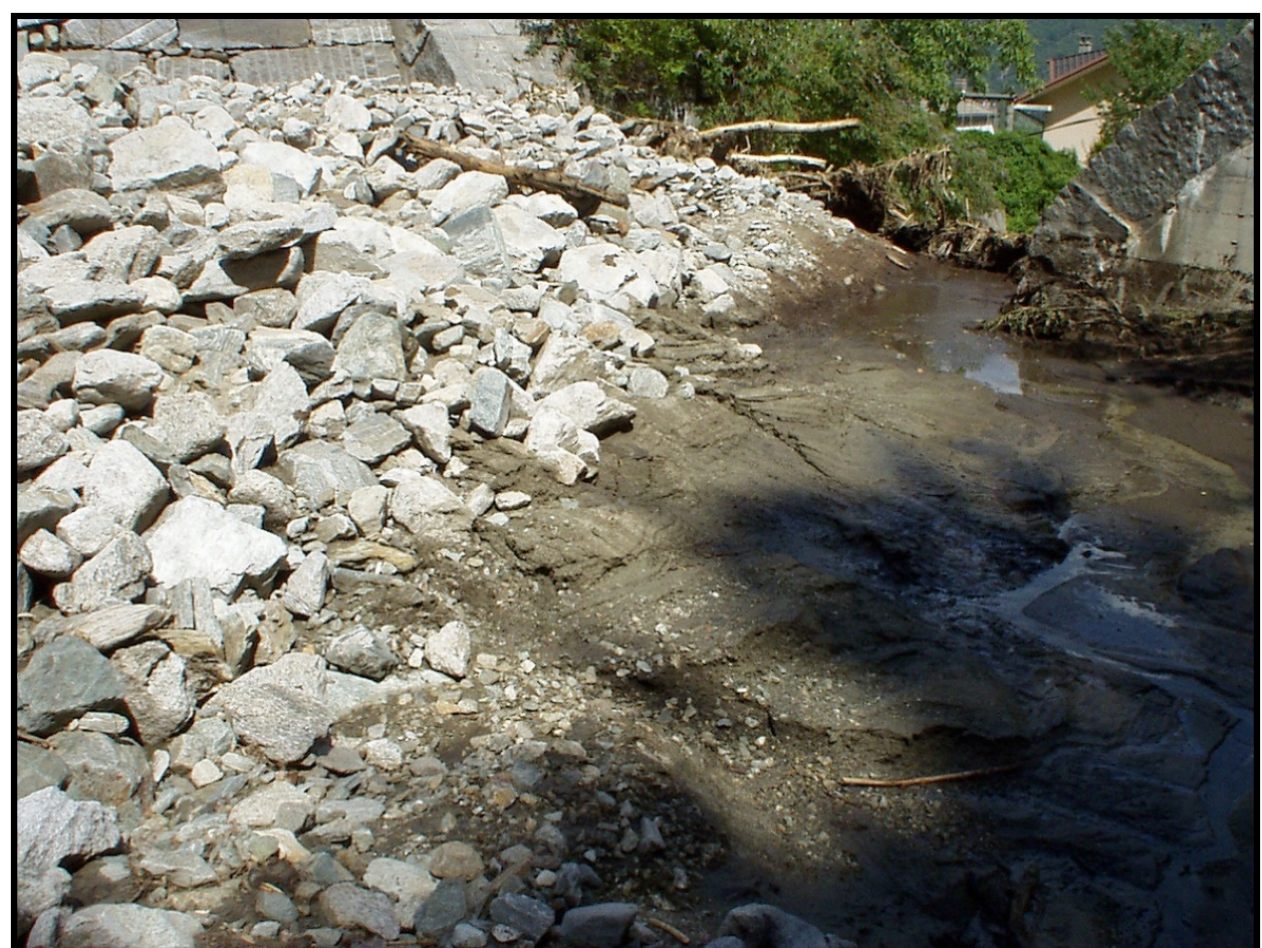
Figure 4. Dark-brown mud sediments below the coarse deposits of 18 July debris flow.